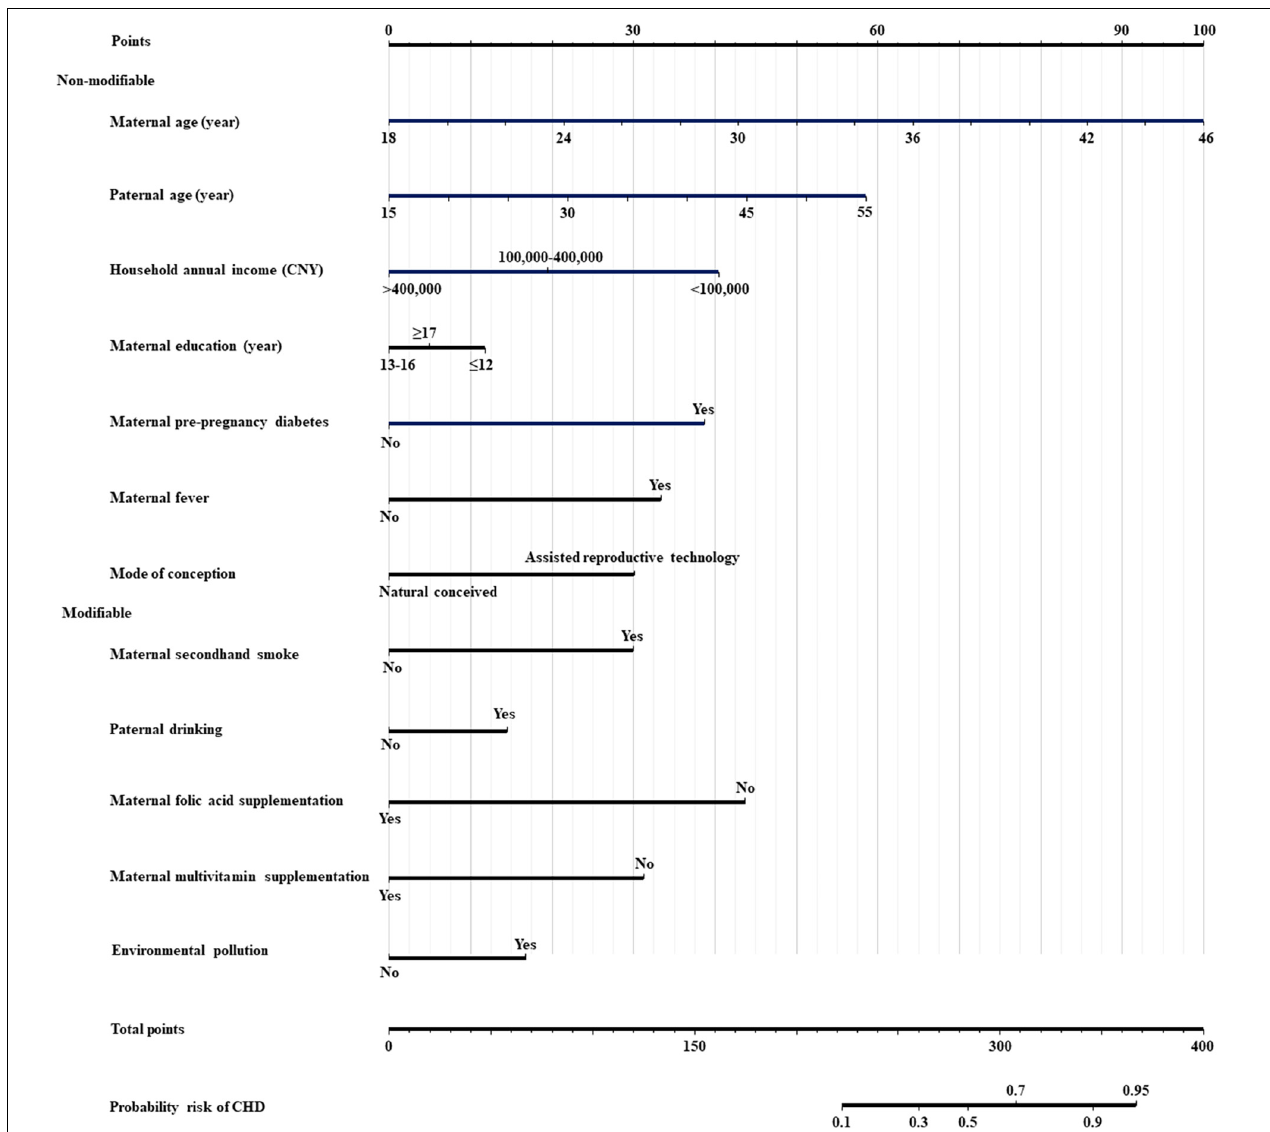
FIGURE 2 | Nomogram for predicting the risk of offspring congenital heart diseases. CNY, china yuan; CHD, congenital heart disease; Modifiable, modifiable factors; Non-modifiable, non-modifiable